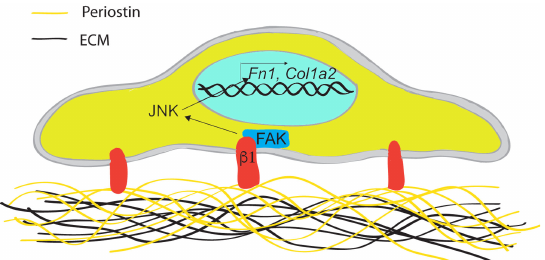
Figure 4. Periostin induces fibronectin and Col1a2 in human gingival fibroblasts in a manner dependent on JNK signaling. Requiring β 1 integrin engagement into adhesion sites and FAK phosphorylation, JNK activation is required to induce a matrix secreting